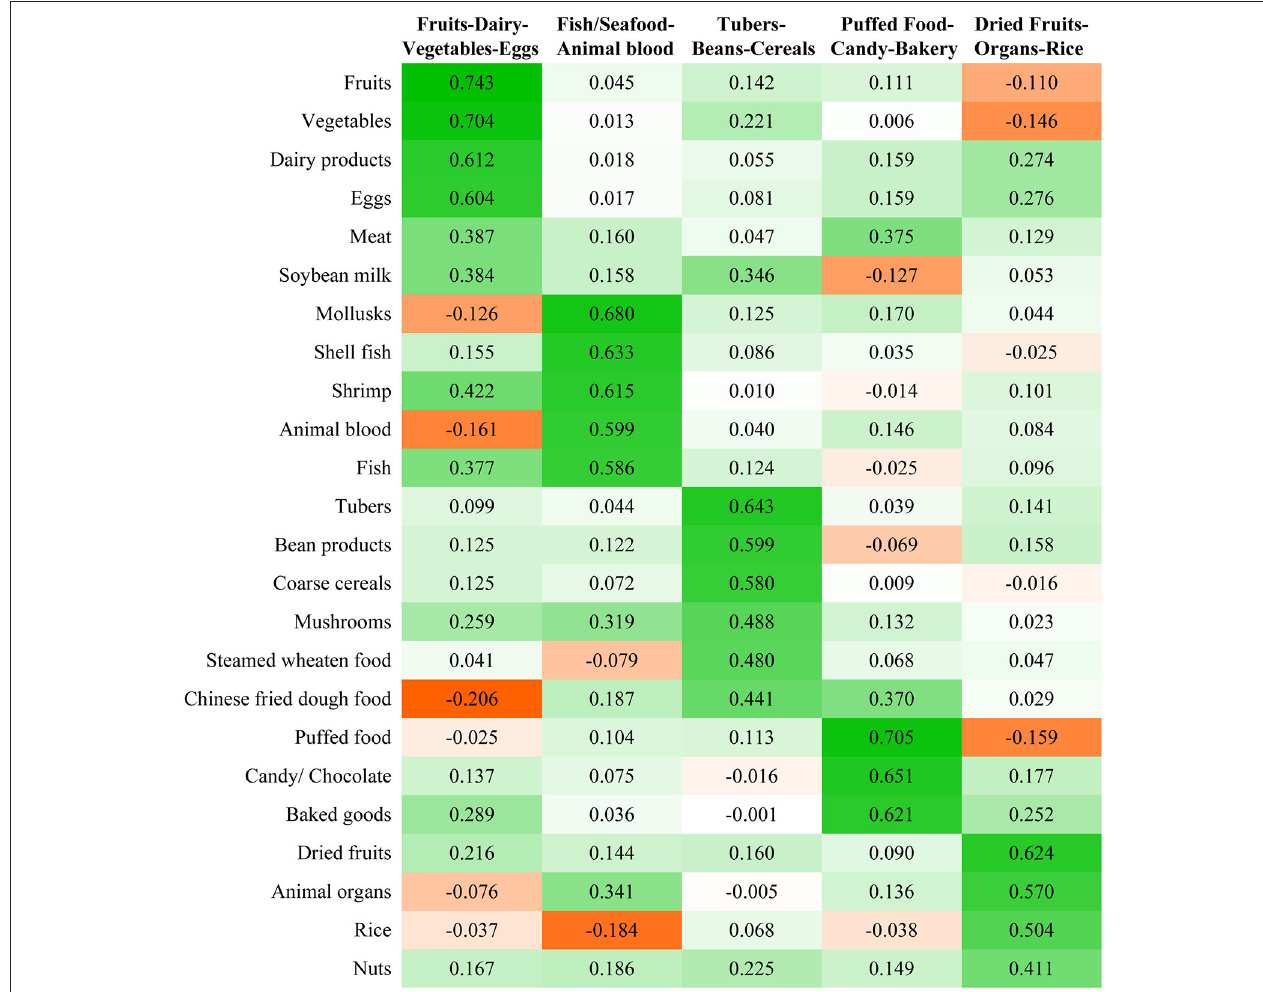
FIGURE 2 | Factor loadings of food groups in each dietary pattern were identified using PCA. The color gradation denotes the strength and direction of the correlation between the food groups and dietary patterns. Deep green represents a relatively higher correlation (a higher intake) of the food groups with the corresponding dietary patterns. Deep orange represents relatively a lower correlation (a lower intake) of the food groups with the corresponding patterns. White represents no correlation between the food groups with the corresponding dietary pattern.